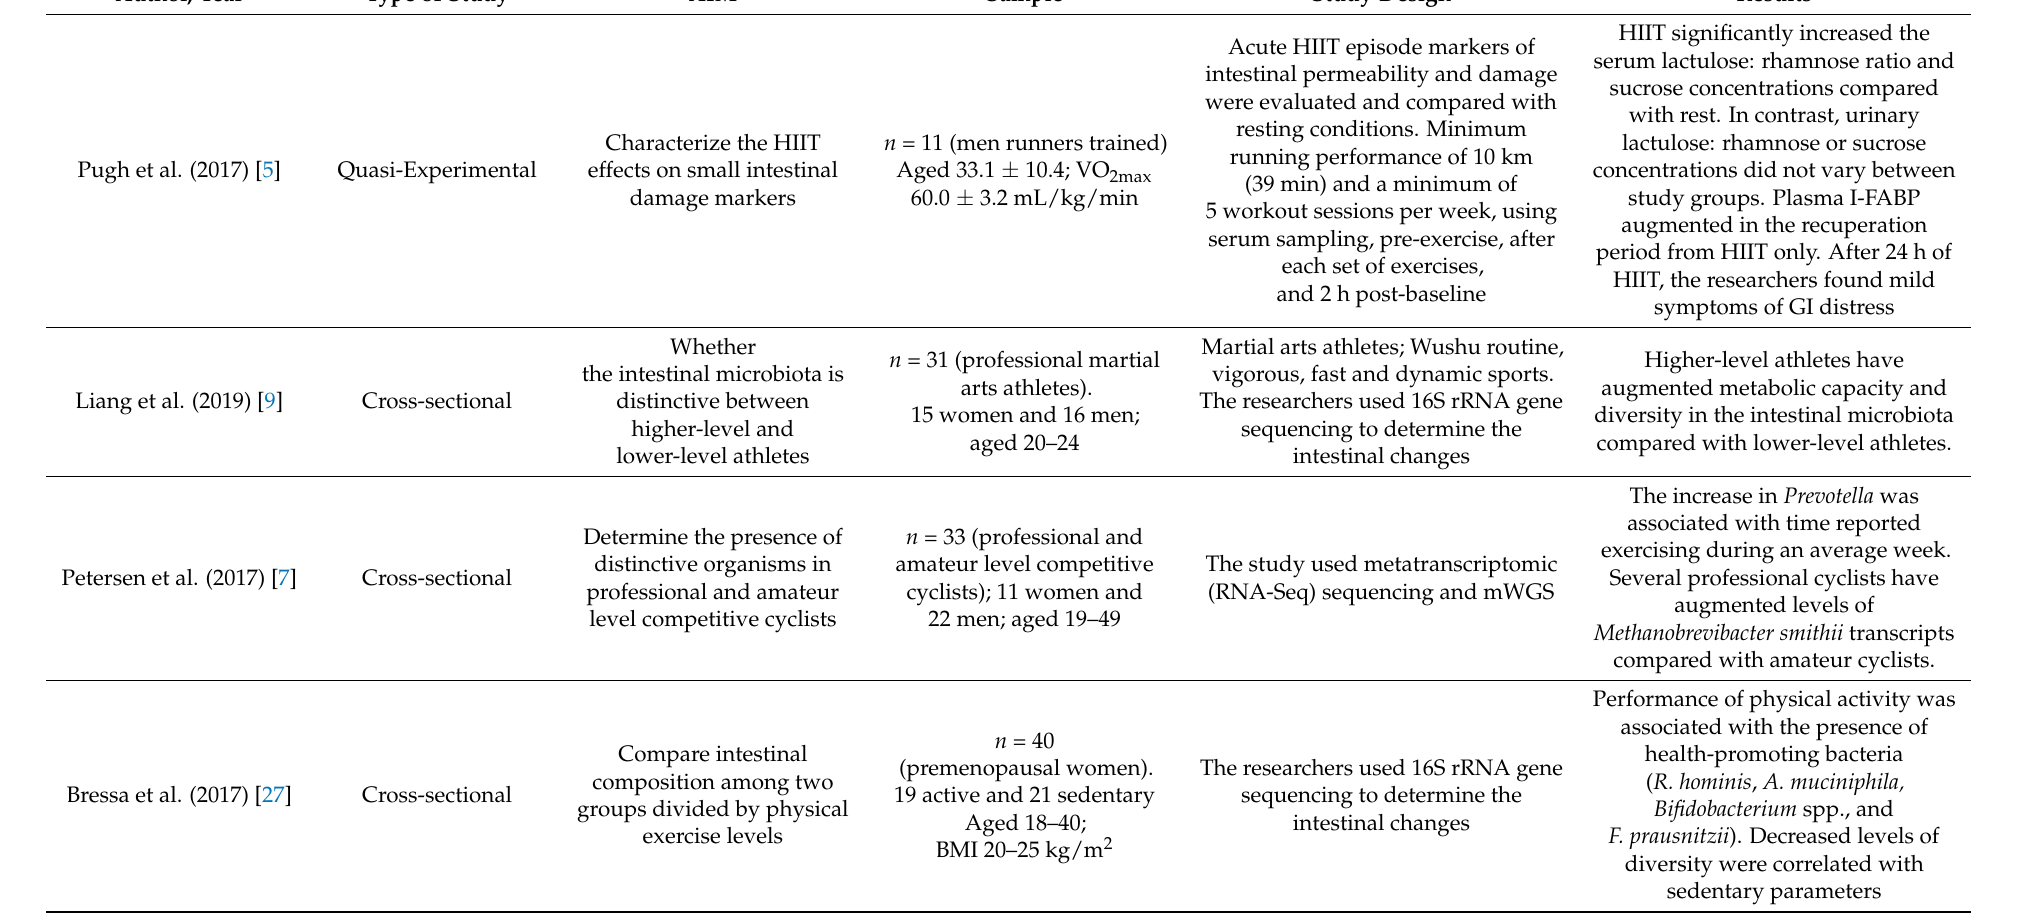
Table 2. Characteristics as the type of study, aim, sample, design, and mean results of the